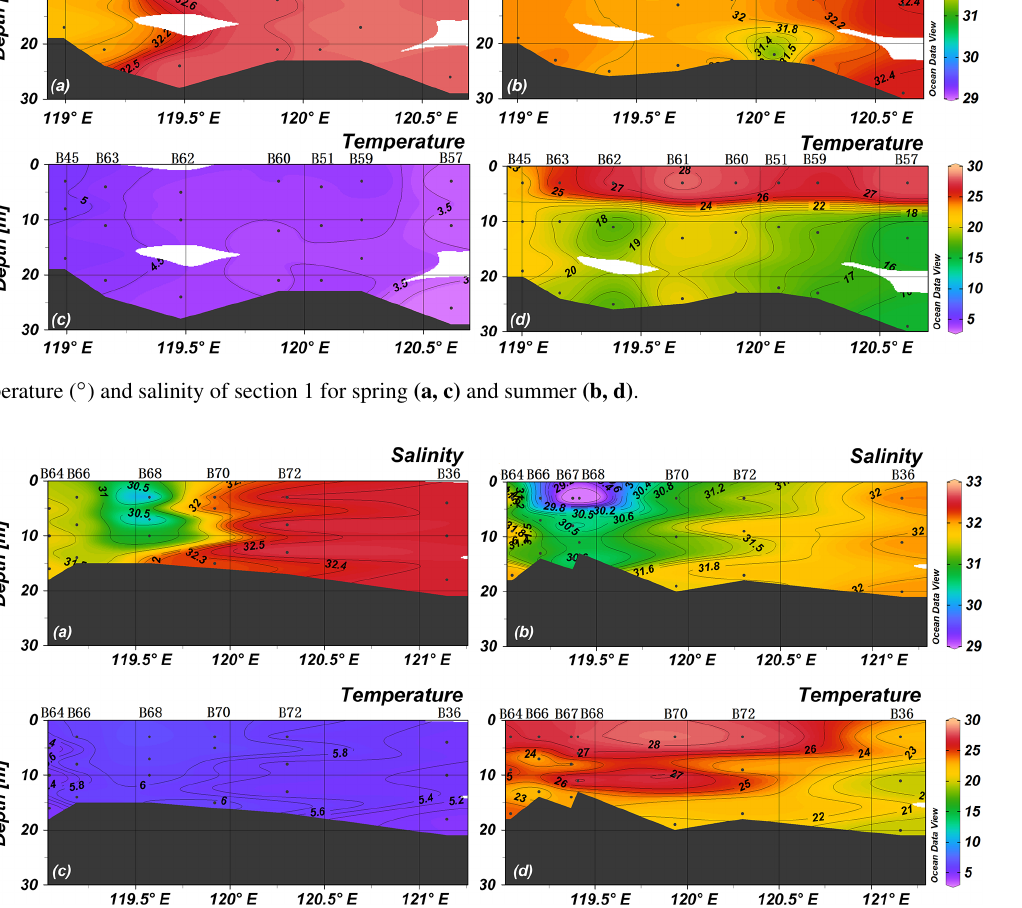
Figure 3. Temperature ( ◦ ) and salinity of section 2 for spring (a, c) and summer (b, d)